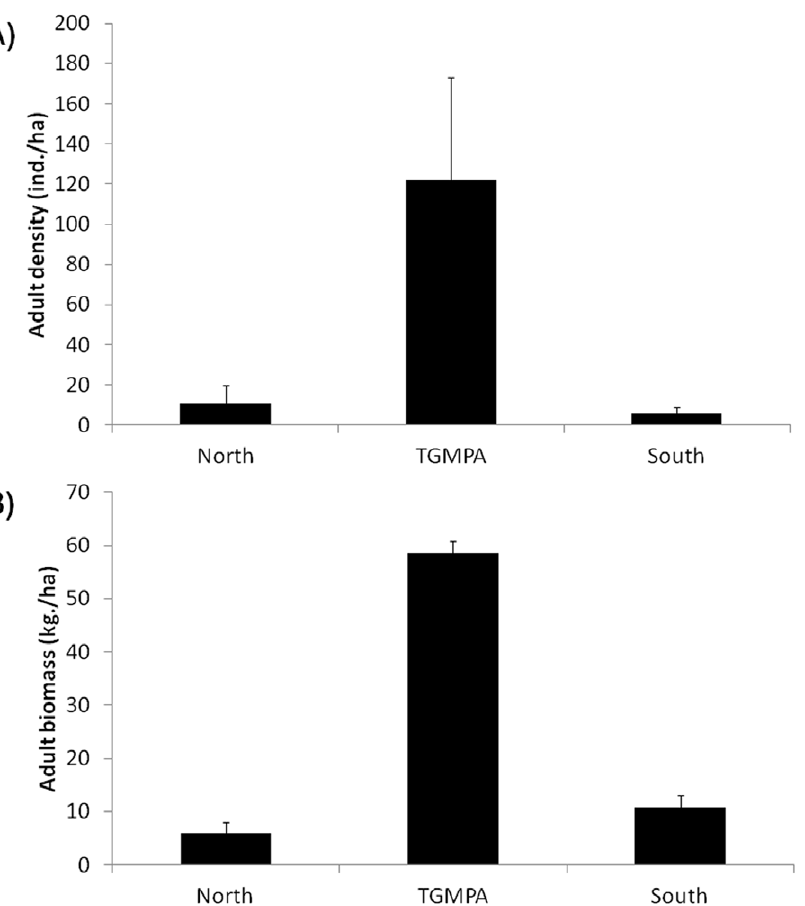
Figure 2. Mean ( ± SE) density (panel A) and biomass (panel B) of adult white sea bream assessed at the three Geographic Areas.